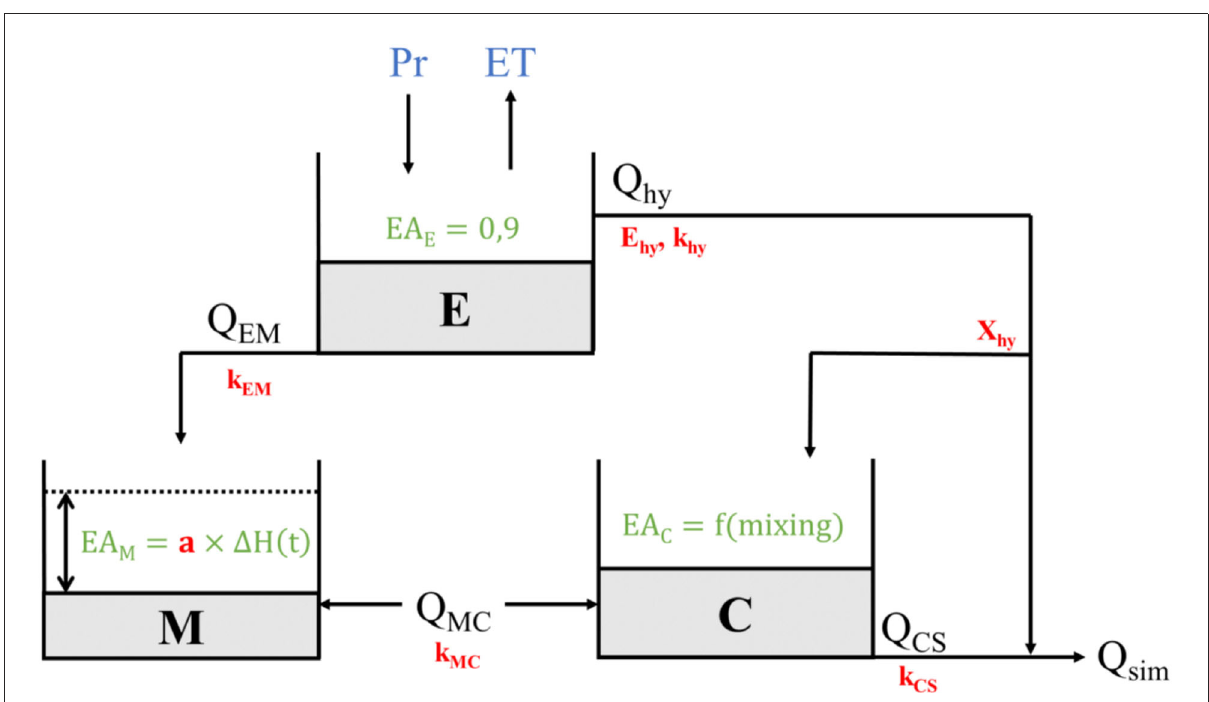
FIGURE3 Lumped parameters model structure. The input variables are given in blue, the compartment and internal fluxes are given in black, the working hypothesis for EA simulation are given in green and the free parameter are given in red. Information about model parameter is given in Table